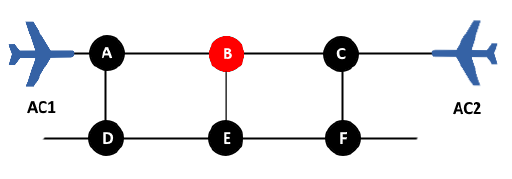
Figure 5. Anticipated head-on conflict example. Node B is the conflict node.